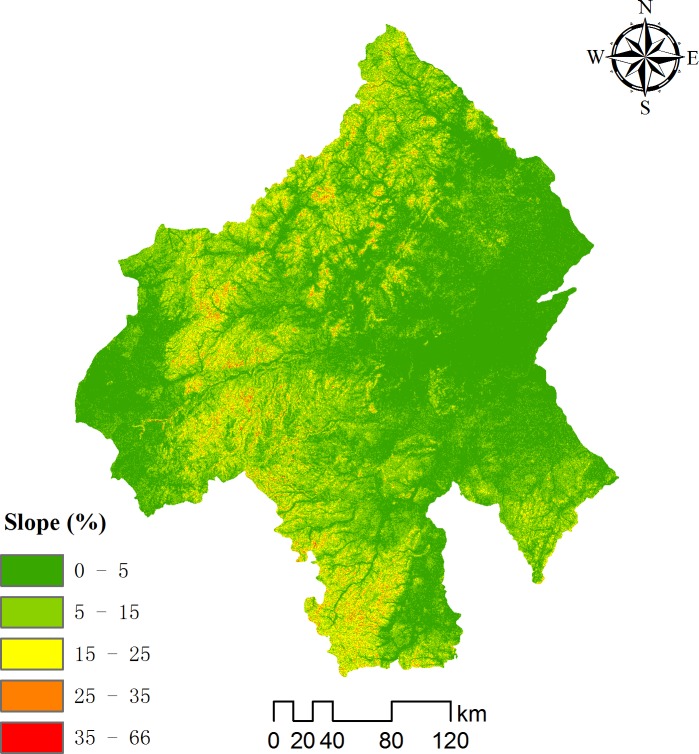
Slope classification of the Chifeng area.